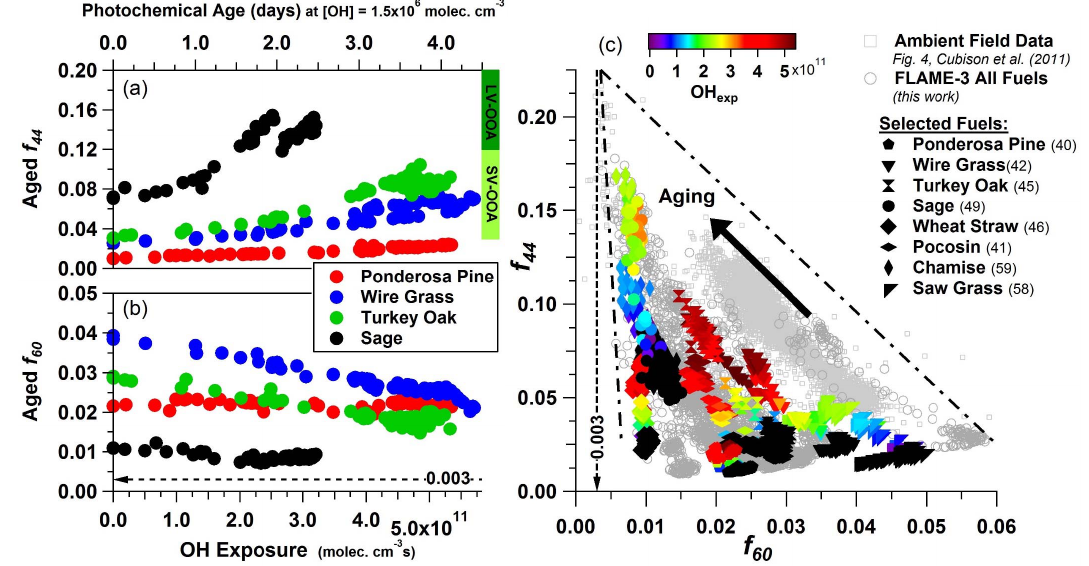
Fig. 10. Fractional contribution of oxidation and biomass-burning tracers evolution with age. (a) f 44 vs. OH exposure for aged smoke from four biofuels. Light- and dark-green bars on the right respectively denote the range of values for semivolatile oxygenated-organic aerosol (SV-OOA) as defined by Ng et al. (2010) and low-volatility oxygenated-organic aerosol (LV-OOA) as defined by Aiken et al. (2009). (b) f 60 vs. OH exposure for aged smoke from four biofuels. Dashed line is ambient background f 60 level in the absence of biomass burning (Cubison et al., 2011). (c) Aging effects on oxidation and biomass-burning markers, f 44 vs. f 60 . Adapted from Cubison et al. (2011) Fig. 5, with unprocessed smoke (black markers) and aged smoke (colored by increasing OH exposure) for eight selected fuels (ponderosa pine, burn 40; wire grass, burn 42; turkey oak, burn 45; sage, burn 49; pocosin, burn 41; wheat straw, burn 46; saw grass, burn 58; and chamise, burn 59). All burns from FLAME-3 (gray circles) and field data from Fig. 4 (gray squares) of Cubison et al. (2011) are presented for